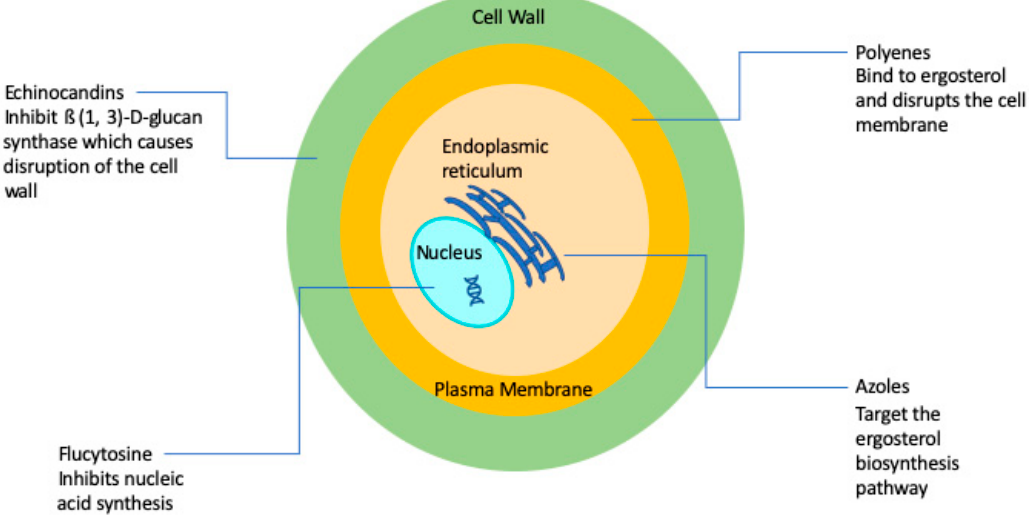
Figure 1. Simplified schematic diagram depicting the current antifungals and their modes of